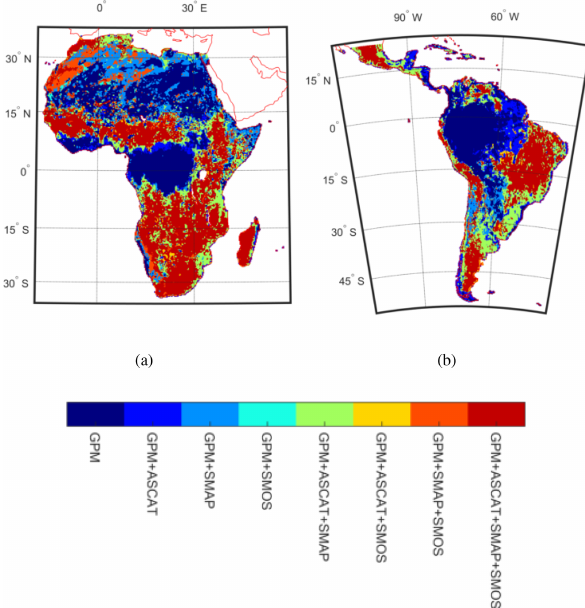
Figure 8. Products used to integrate IMERG-ER with SM2RAIN products derived from the setup during the calibration period in South America. When low correlation was found between the refer- ence dataset (i.e. GPCC) and the SM2RAIN product, the latter was excluded from the analysis, and only IMERG-ER was